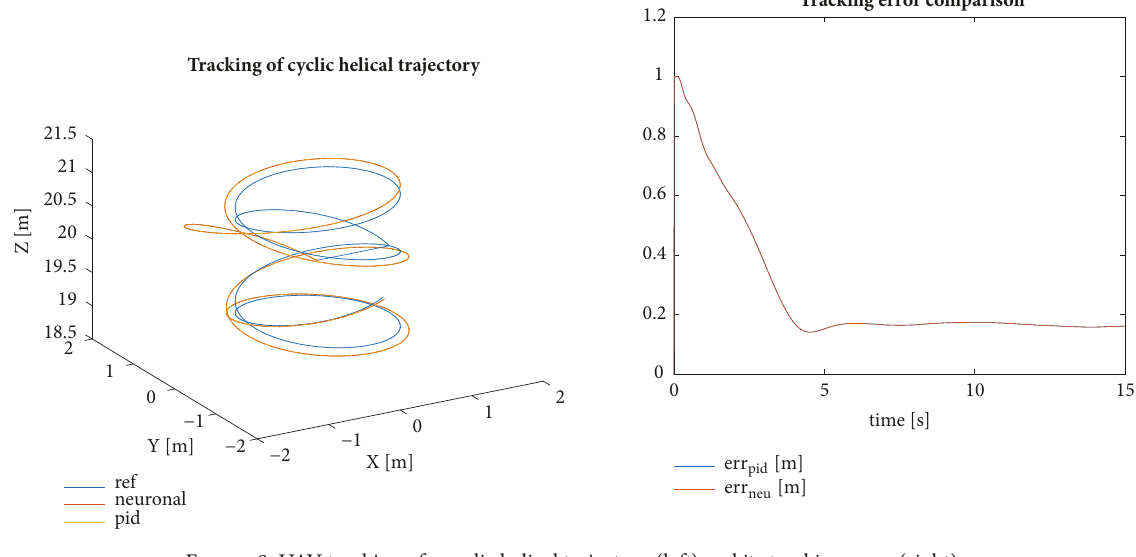
Figure 9: UAV tracking of a cyclic helical trajectory (left) and its tracking error (right).